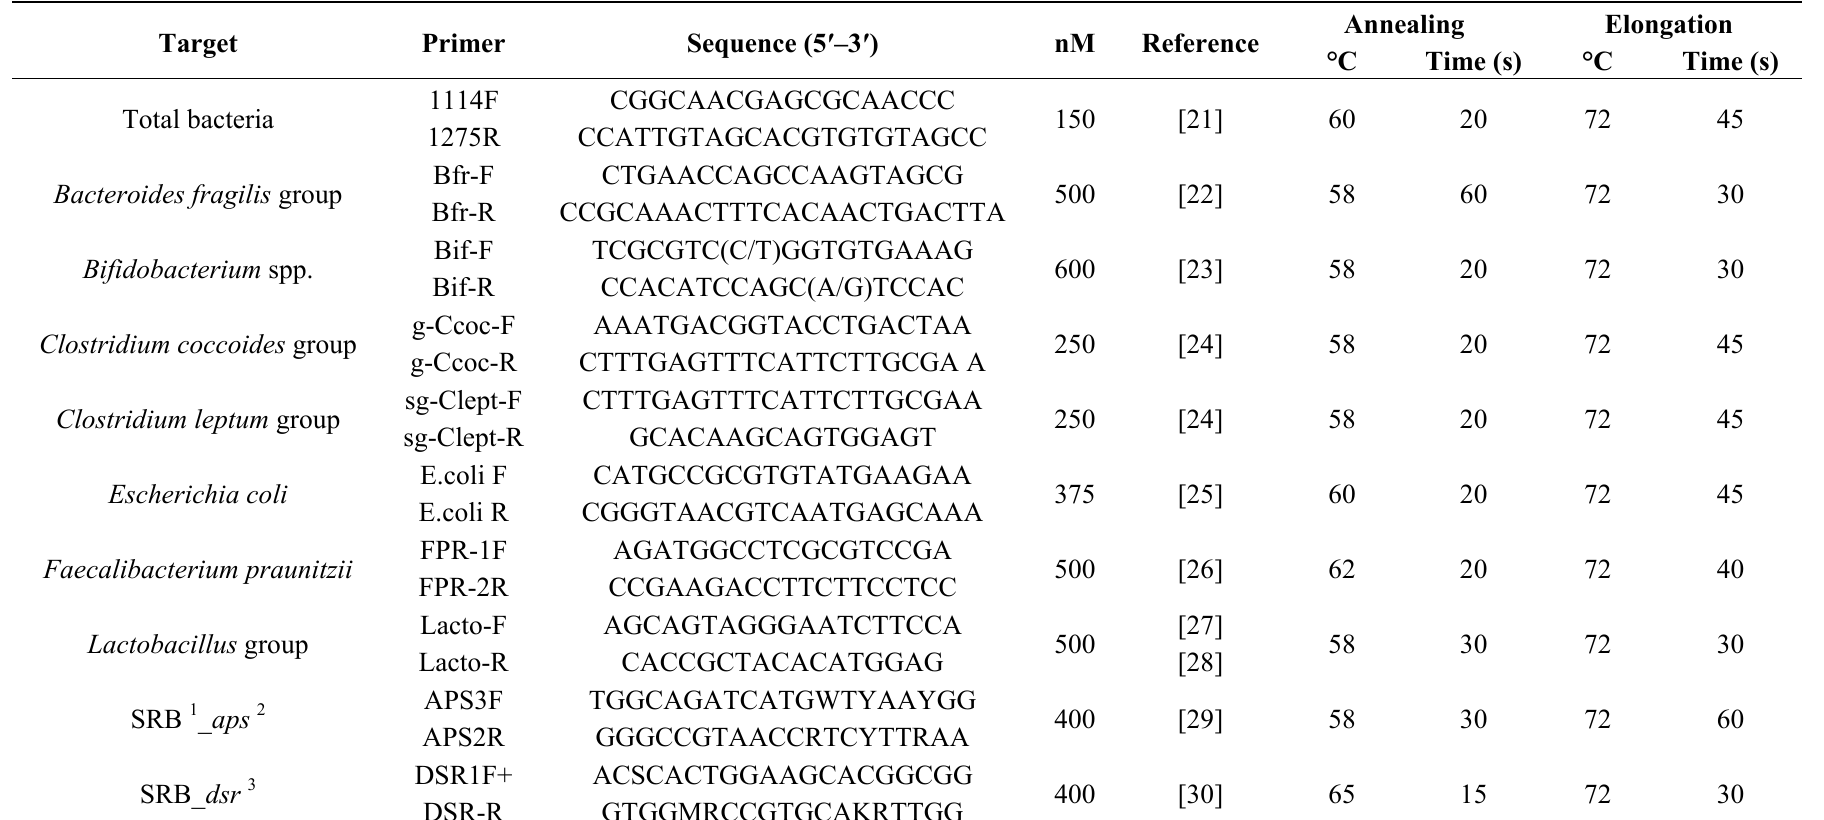
Table 1. Primers and amplification conditions for real-time PCR